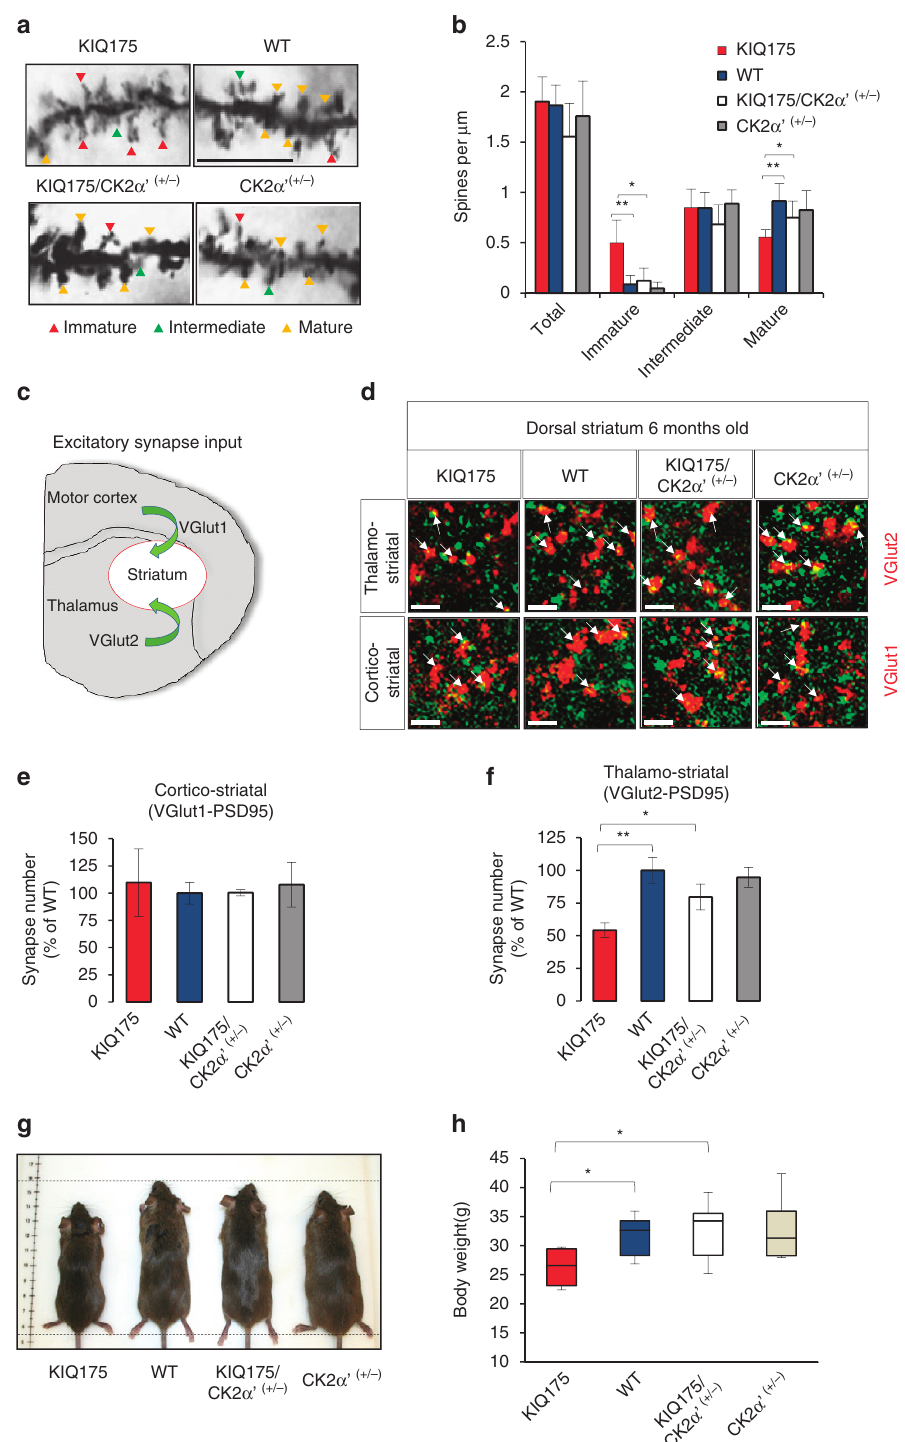
Figure 8 | CK2 a 0 heterozygosity ameliorates biochemical and neurobiological defects in KI175 HD mice. ( a , b ) Dendrite spine number and morphology of MSNs in the dorsal-striatum of KIQ175 and KIQ175/CK2 a 0 þ / (cid:2) at 6 months. Scale bar, 10 m m. Error bars indicate mean ± s.e.m., ( n ¼ 12 cells/animal, 3 animals/genotype). Unpaired t -test * P o 0.05, ** P o 0.01. ( c ) Excitatory synapse input in the dorsal striatum. ( d ) Immunostaining of the cortico-striatal pre-synaptic marker (VGlut1, red), the thalamo-striatal pre-synaptic marker (VGlut2, red) and the post-synaptic marker PSD95 (green) in the dorsal-striatum of KIQ175, WT, KIQ175/CK2 a 0 þ / (cid:2) , and CK2 a 0 þ / (cid:2) at 6 months. Scale bar, 10 m M. ( e ) Quantification of VGlut1-PSD95 and ( f ) VGlut2-PSD95 co-localized synaptic puncta from B. Error bars indicate mean ± s.e.m., ( n ¼ 3 animals per genotype, 3 sections per animal, 15 sections ( n ¼ 11) at 6 months. Error bars indicate ± s.e.m. Unpaired t -test * P o